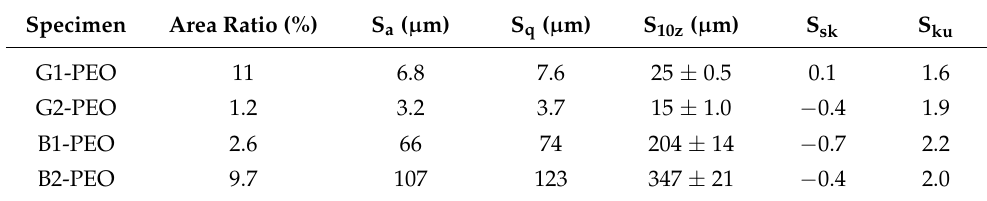
Figure 8. TD profiles of G1-PEO and G2-PEO specimens. Table 5. Surface descriptors of the flash-PEO-treated specimens obtained via 3D metrology. S a : average surface roughness. S q : square root average surface roughness. S10z: ten-point average height. S sk : skewness parameter. S ku : kurtosis parameter.